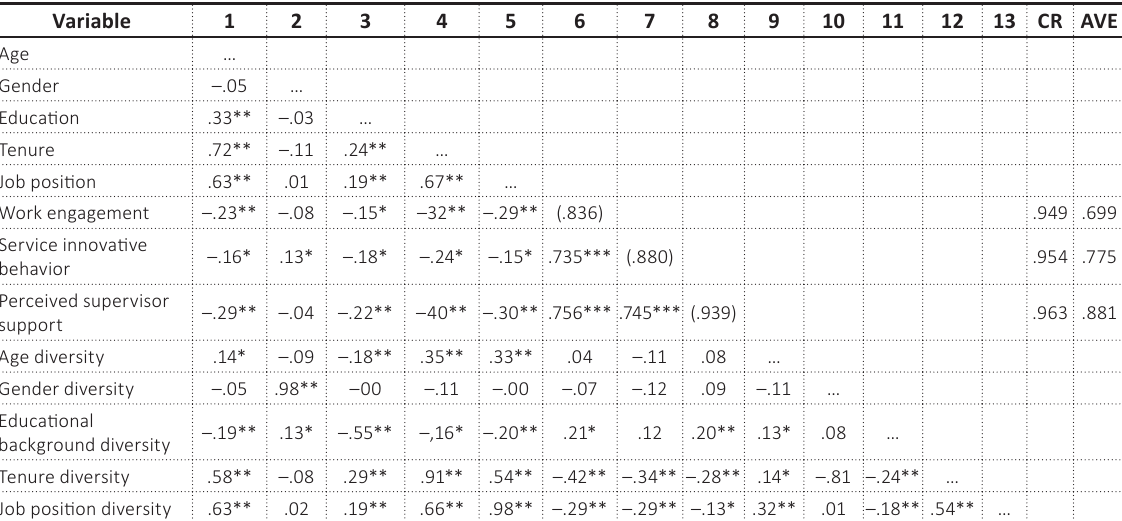
Table 2. Correlation matrix and variance extracted